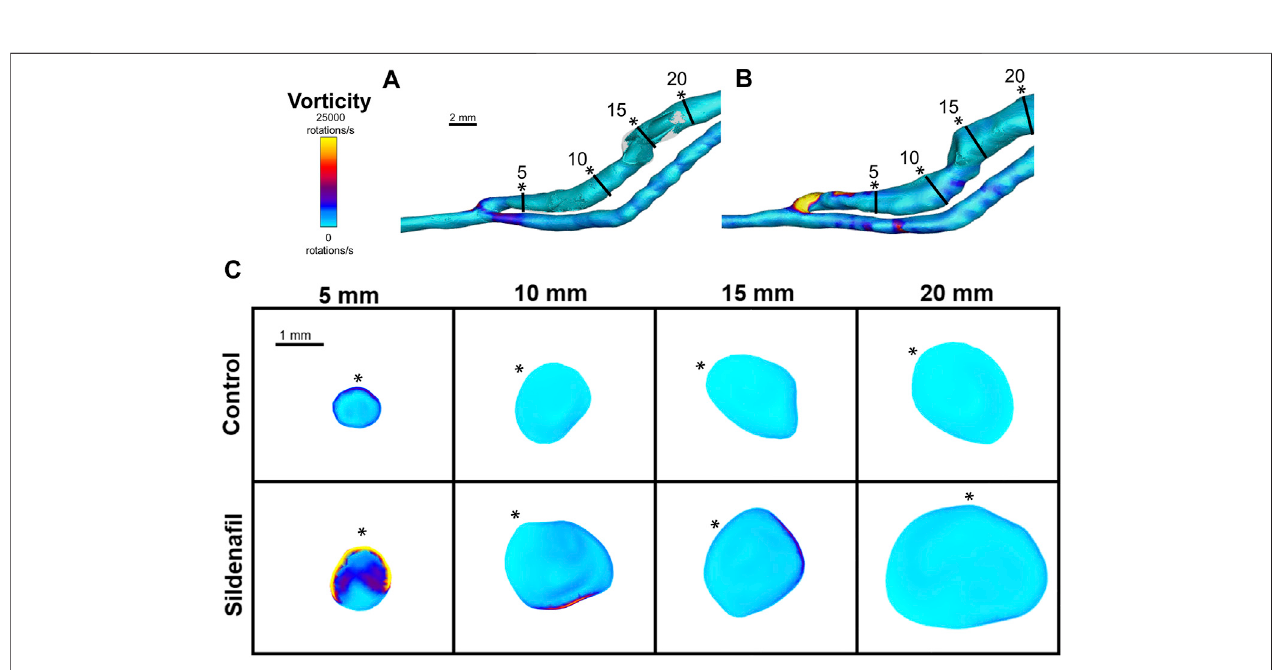
FIGURE 8 | Vorticity isosurface and color maps. (A,B) Vorticity isosurface for AVFs in a control rat (A) and a sildena fi l treated rat (B). (C) Color maps of vorticity for controland sildena fi ltreated ratsat 5,10, 15,and 20 mm awayfrom theanastomosis.Blacklines inpanels Aand Brepresent theslicelocations.* inpanel Crepresents the top of the slice as shown in panels A and B. Color bar applies to (A – C) . Scale bar in A applies to (A – B)